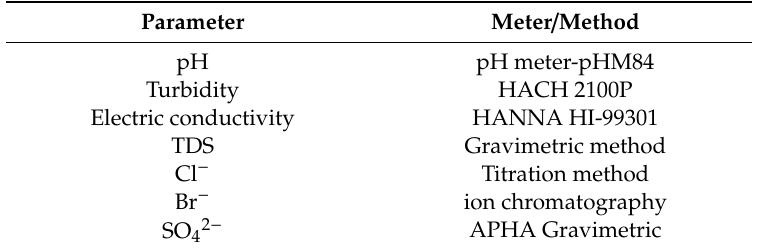
Table 2. Parameters and methods of the analyses.